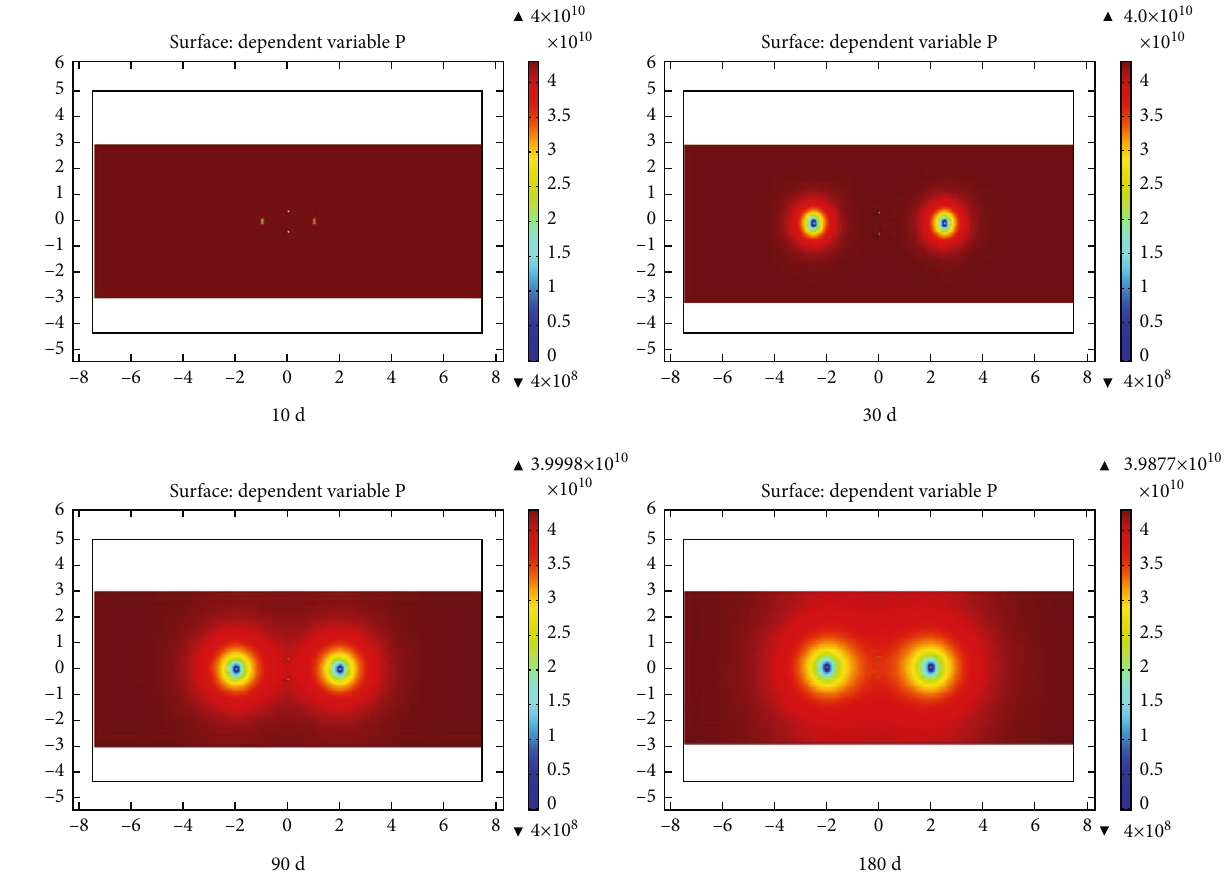
Figure 13: Gas pressure distribution map of liquid carbon dioxide fracturing with 4m spacing between pumping